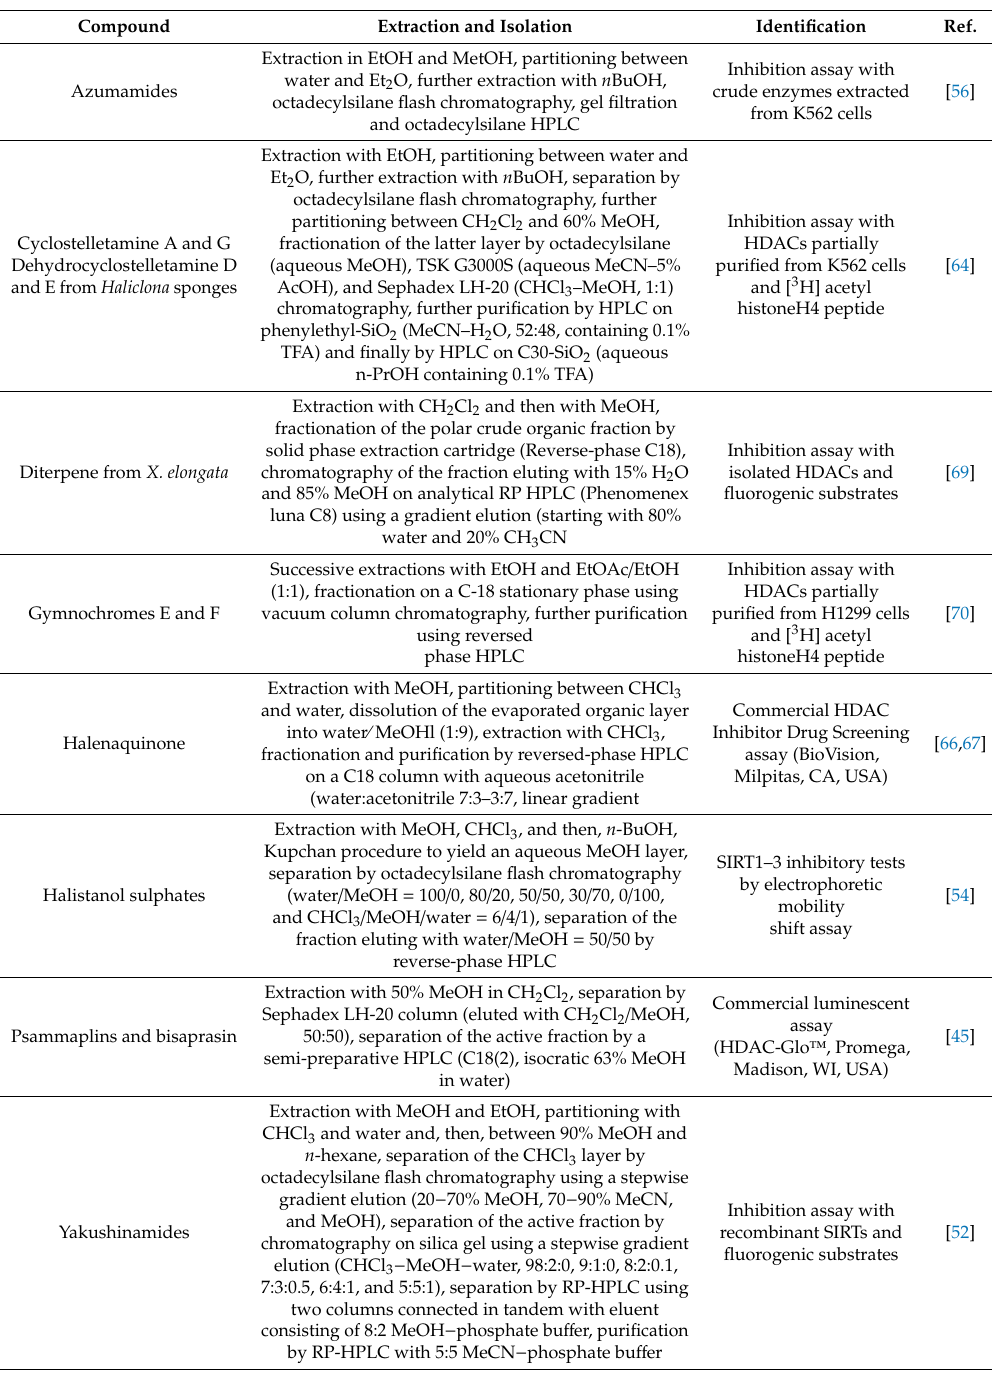
Table 1. Extraction, isolation, and identification procedures for the inhibitory histone deacetylases (HDACis) from marine